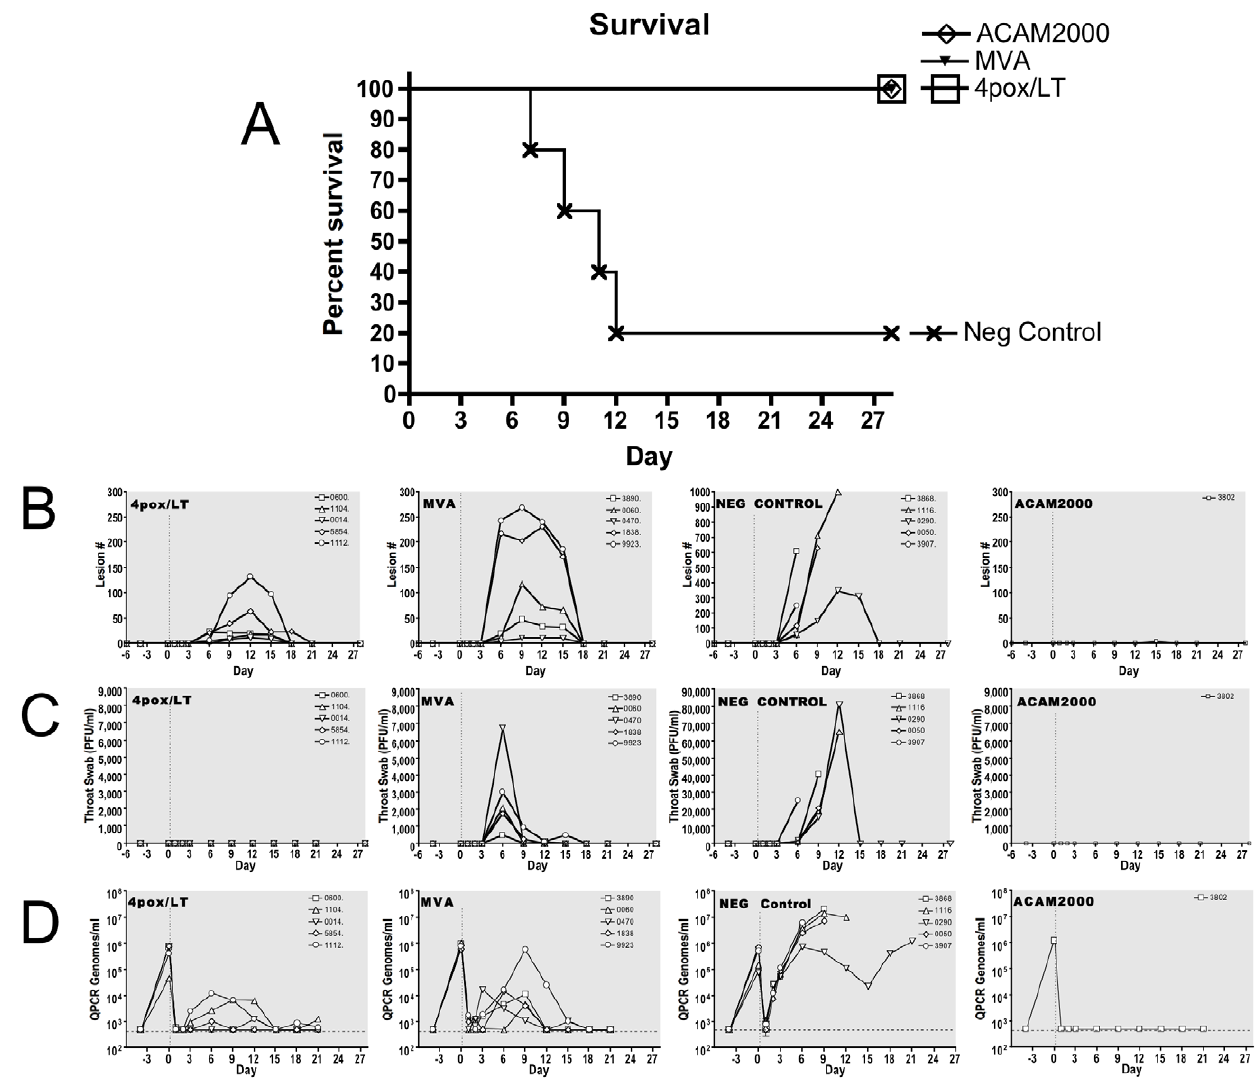
Figure 4. MPXV challenge of vaccinated NHPs. Groups of vaccinated NHPs were challenged with 2 6 10 7 pfu of MXPV strain Zaire-79 by the intravenous route. A. Survival was monitored out to 28 DPI. Moribund animals were euthanized and the percent survival was plotted. The 4pox/LT and MVA vaccines exhibited a significant level of protection relative to the negative controls as measured by % survival (p-value 0.0145) and survival curve (p-value 0.0399) B. Pox lesions on infected NHPs were counted on days 0, 1, 2, 3, 6, 12, 15, 18, 21, and 28. Lesions were individually counted on the hands, feet, torsos, face, mouth arms and legs. The total lesion count per animal from each time-point is plotted. C. Shedding of viable virus from the throat was monitored on days 0, 1, 2, 3, 6, 12, 15, 18, 21, and 28 by plaque assay as described in the materials and methods. D. MPXV genomes in the whole blood of the animals were determined at the indicated time-points by quantitative PCR. The day 0 blood sample was collected immediately after i.v. injection of the challenge virus. The assay limit was 500 genomes per